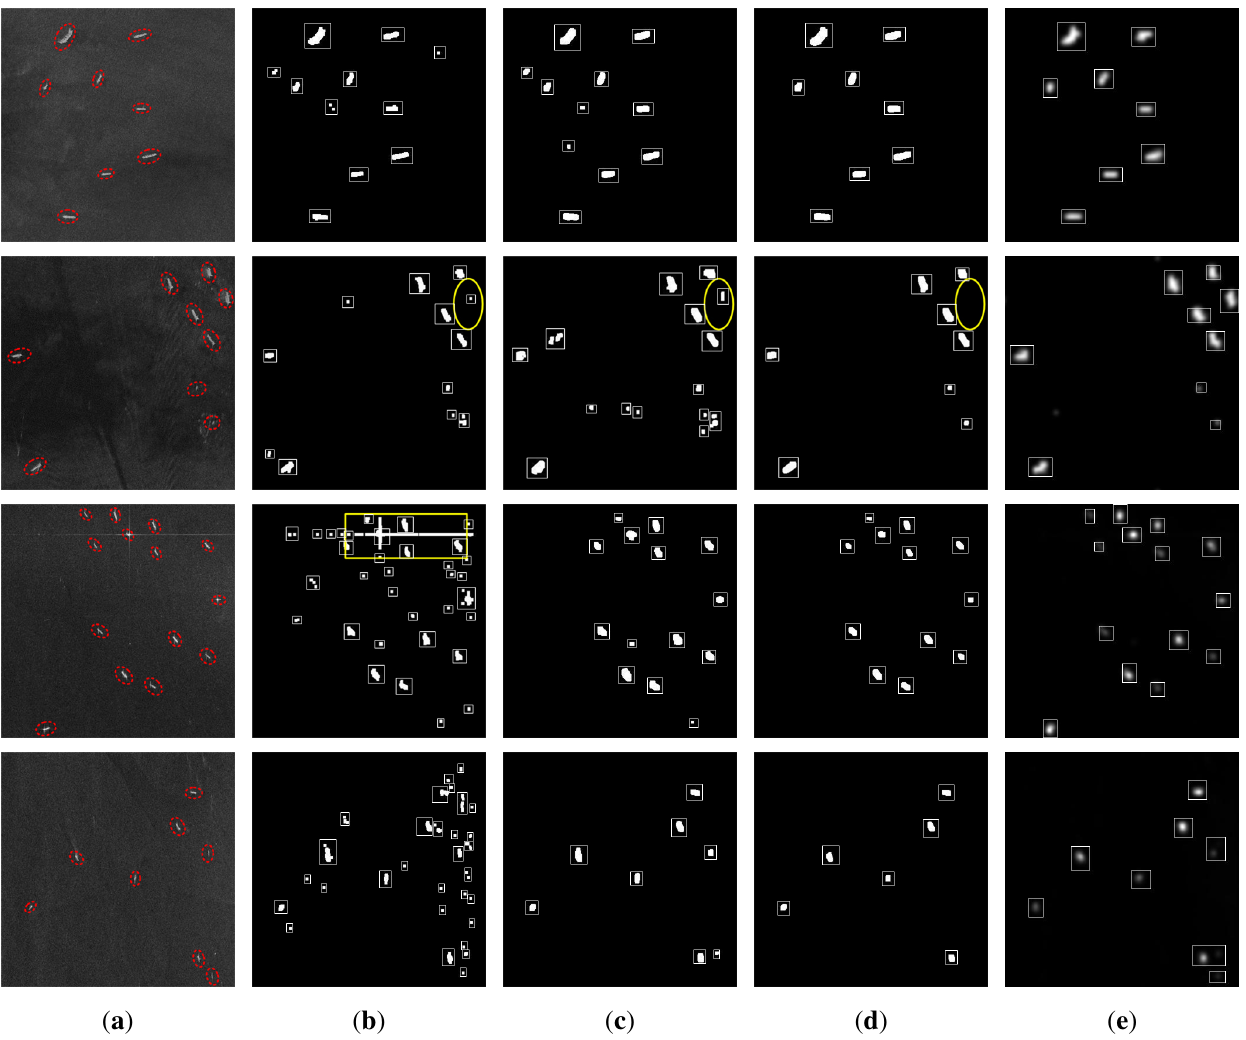
Figure 5. Results of ship target detection for SAR images with a simple scene by different algorithms. ( a ) Original SAR image with ship targets marked by red ovals. ( b – d ) The results of Nakagami-constant false alarm rate (CFAR), Weibull-CFAR and G 0 -CFAR, respectively, with detected objects marked in white boxes. ( e ) The results of the proposed